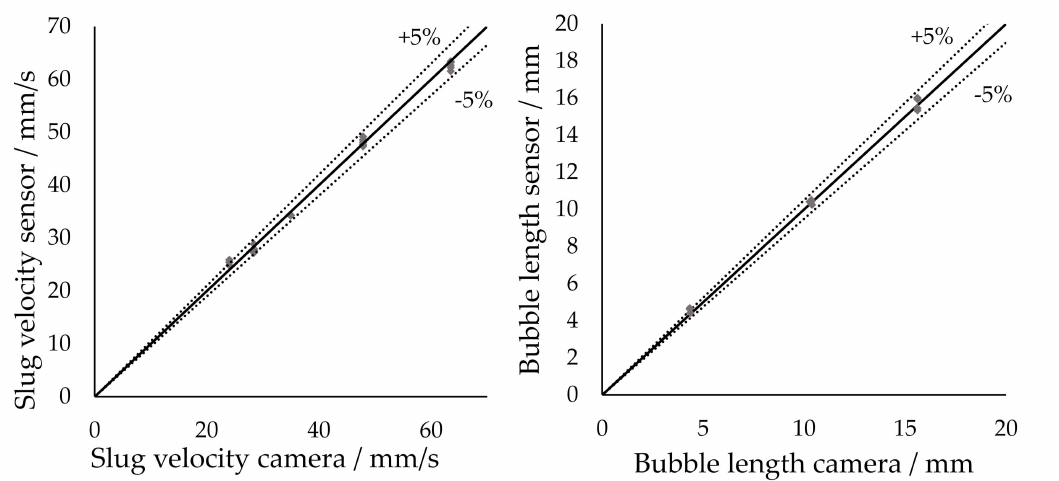
Figure 14. Parity diagrams to compare the performance of the transmissive sensor with the evaluation method presented to camera-determined values. Left: Slug velocity. Right: Bubble